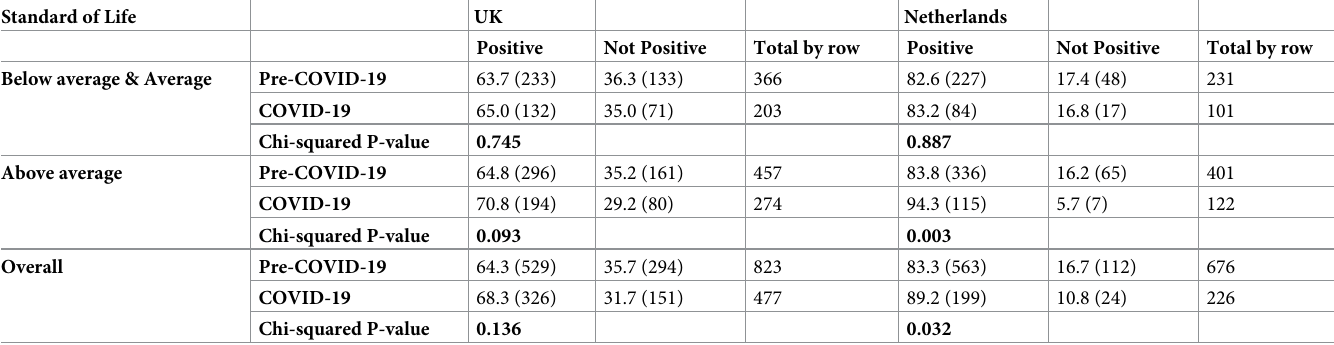
Table 6. Standard of life and childbirth experiences of the included participants. Standard of